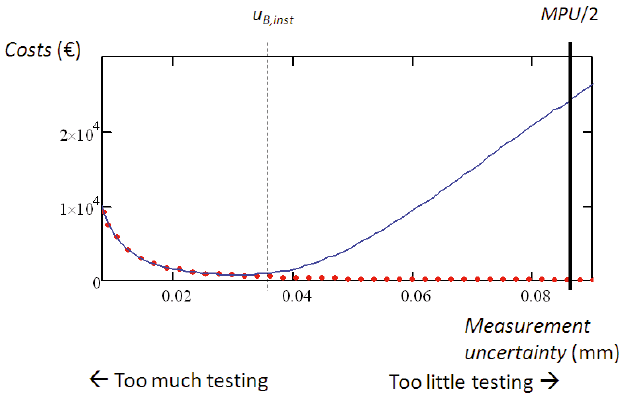
Fig. 4. Optimised uncertainty analysis for conformity assess- ment of vehicle closure panel gap for observation 179